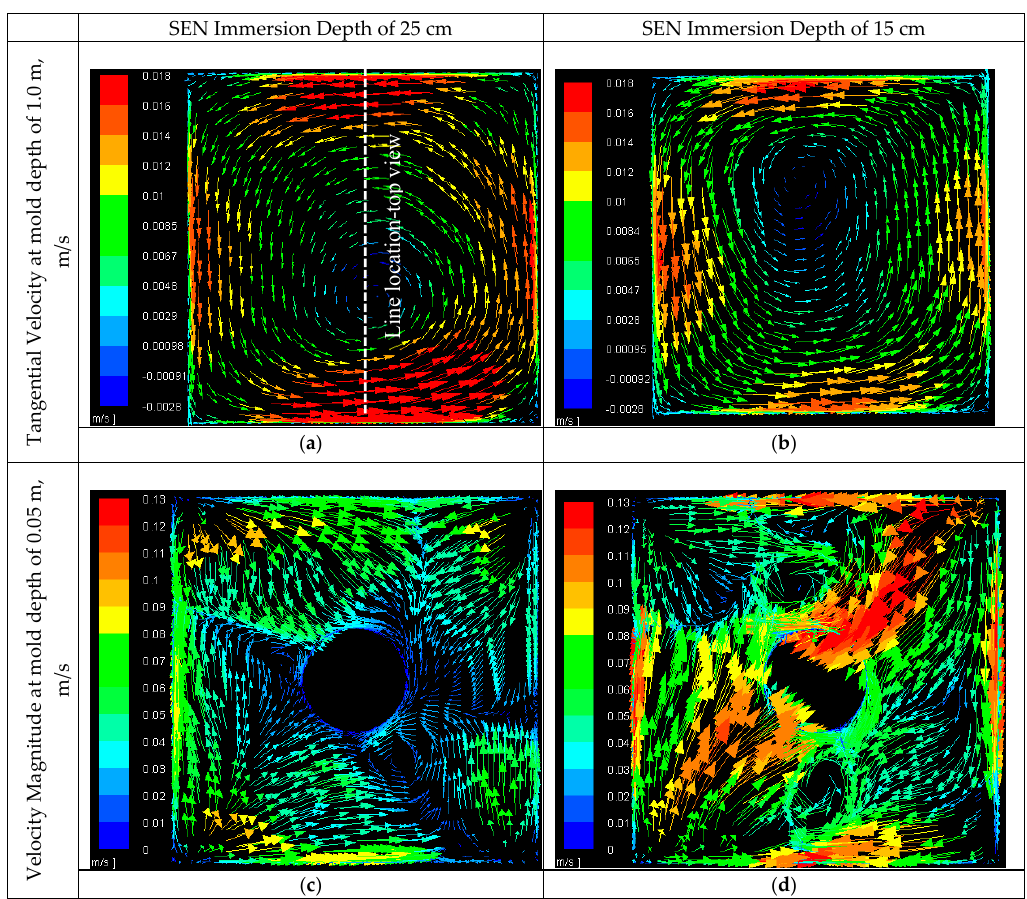
Figure 5. Velocities on different cross sections of the mold at different mold depths and SEN immersion depths, ( a ) tangential velocity for SEN depth of 0.25 m and mold depth of 1.0 m, ( b ) tangential velocity for the SEN depth of 0.15 m and mold depth of 1.0 m, ( c ) velocity magnitude for the SEN depth of 0.25 m and mold depth of 0.05 m and ( d ) velocity magnitude for the SEN depth of 0.15 m and mold depth of 0.05 m. Metals 2018 , 8 , x FOR PEER REVIEW